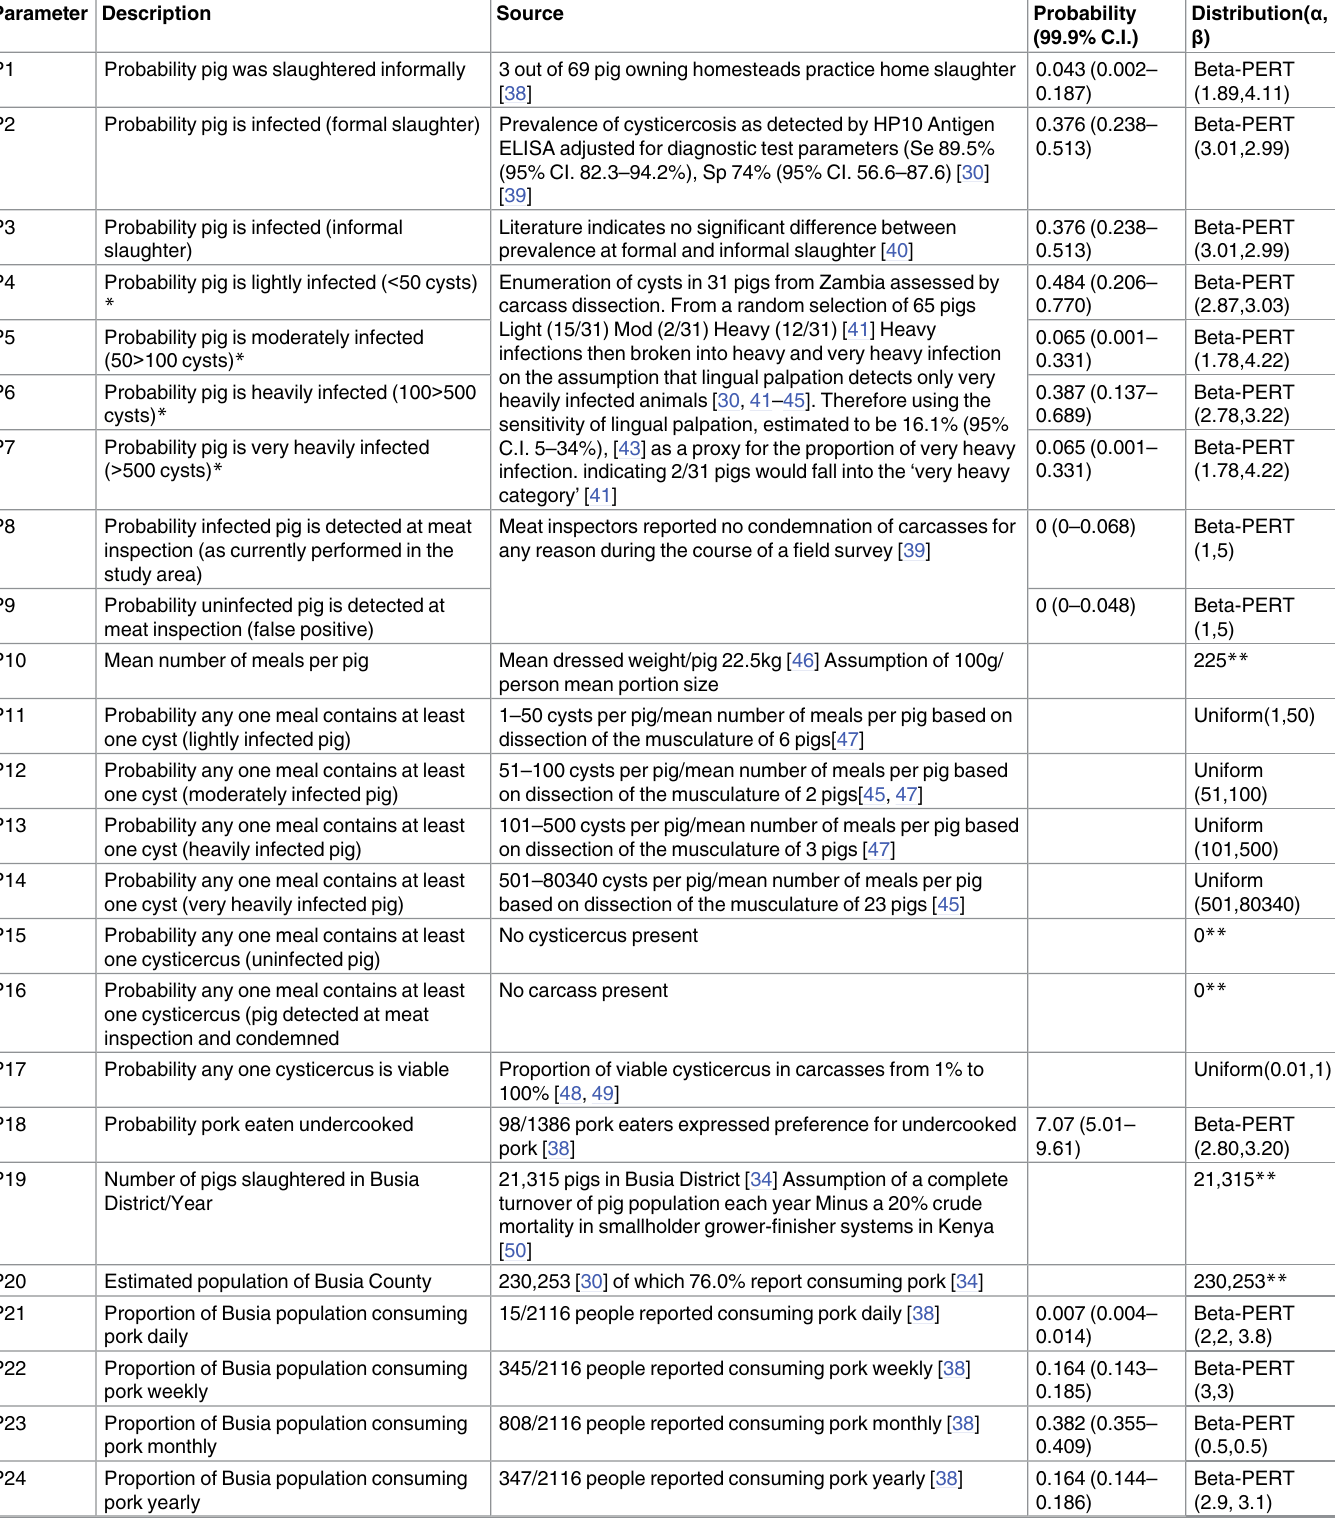
Table 1. Description of model